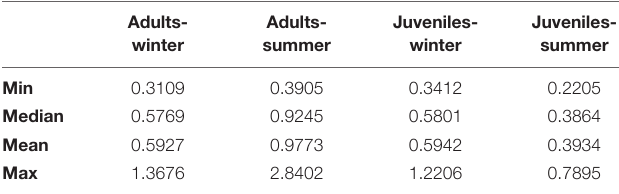
TABLE 4 | Bayesian Standard Ellipses Area (SEA B ) values for each life stage (Adult-Juvenile) and each season